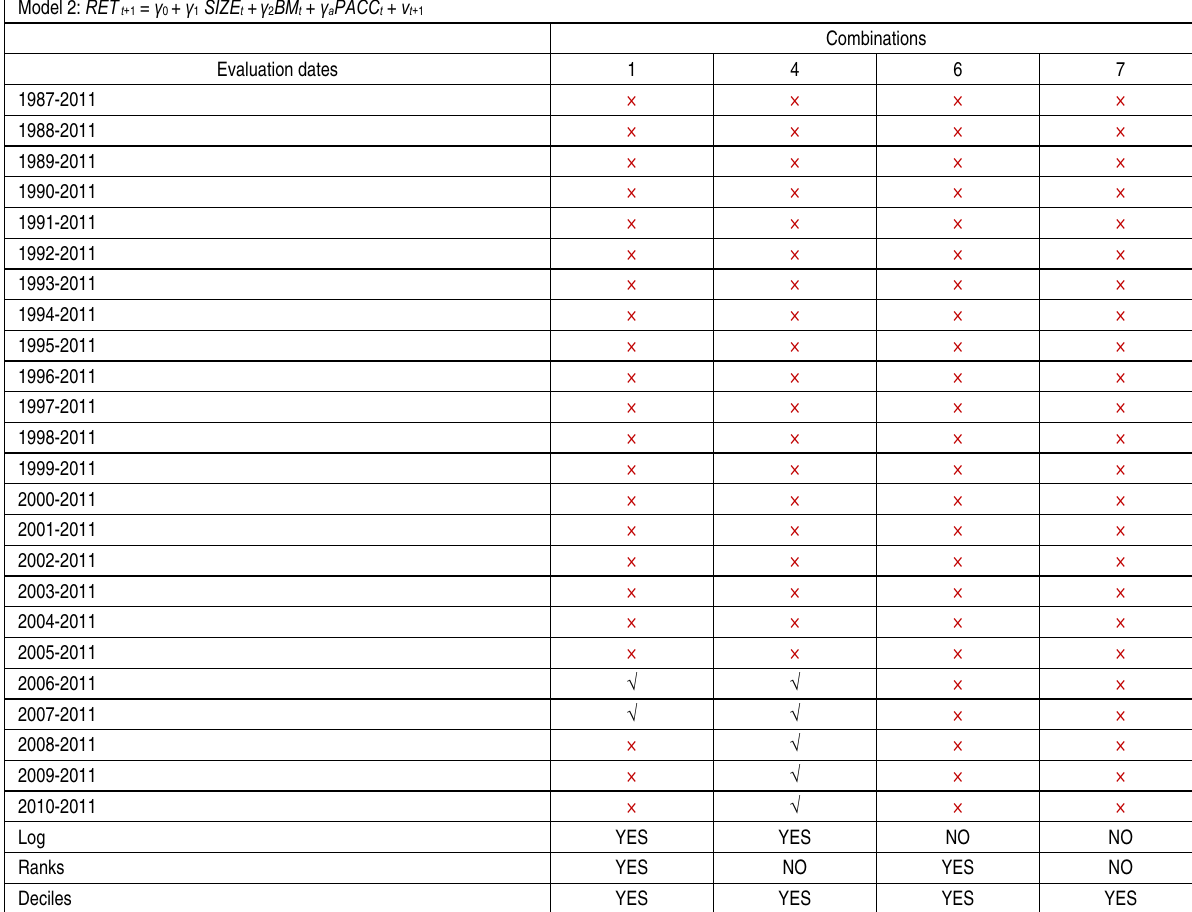
Table 5. Significance of regression estimates for PACC